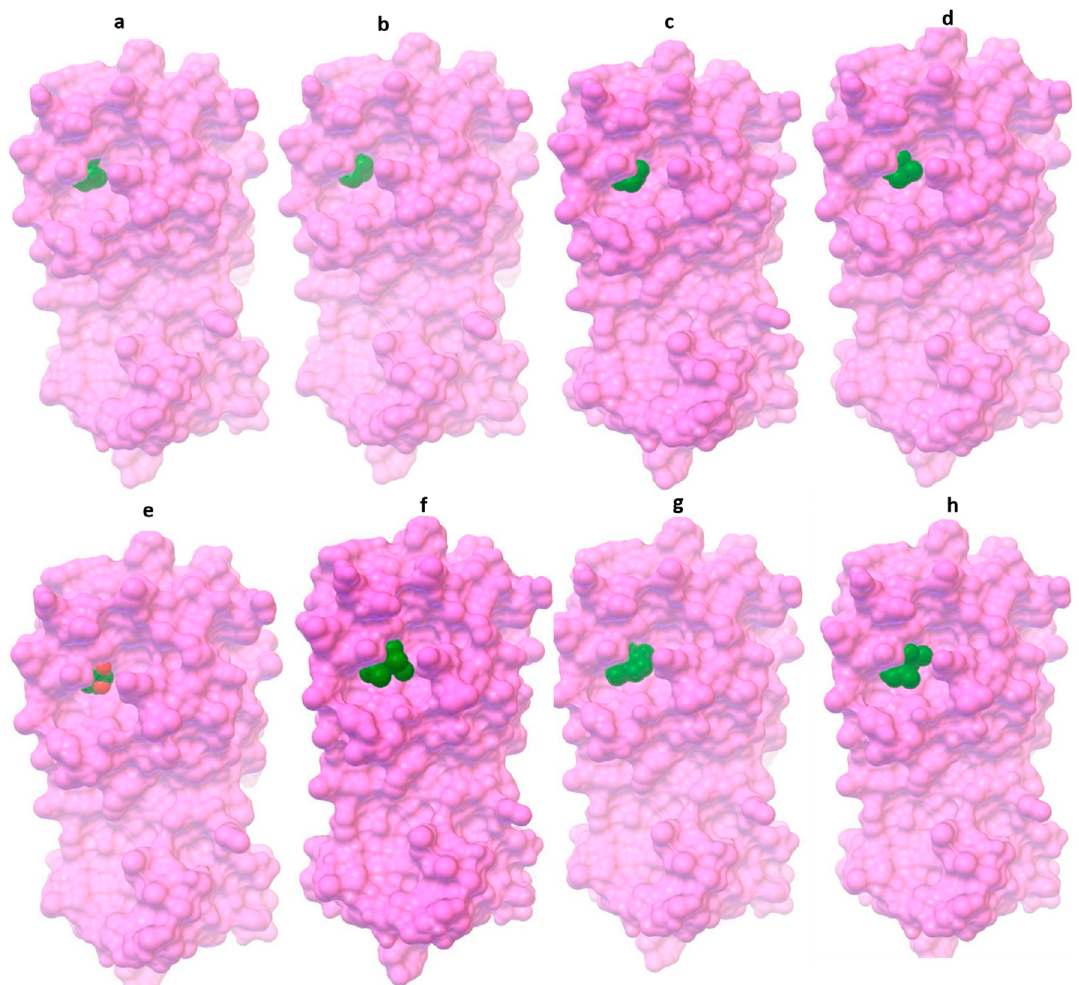
Figure 3. Docking structure of Mpro in complex with eucalyptus compounds: ( a ) 1, 8-cineole (eucalyptus), ( b ) α -pinene, ( c ) β -pinene, ( d ) terpinen-4-ol, ( e ) piperitone, ( f ) allo-aromadendrene, ( g ) aromadendrene, and ( h ) α -gurjunene.